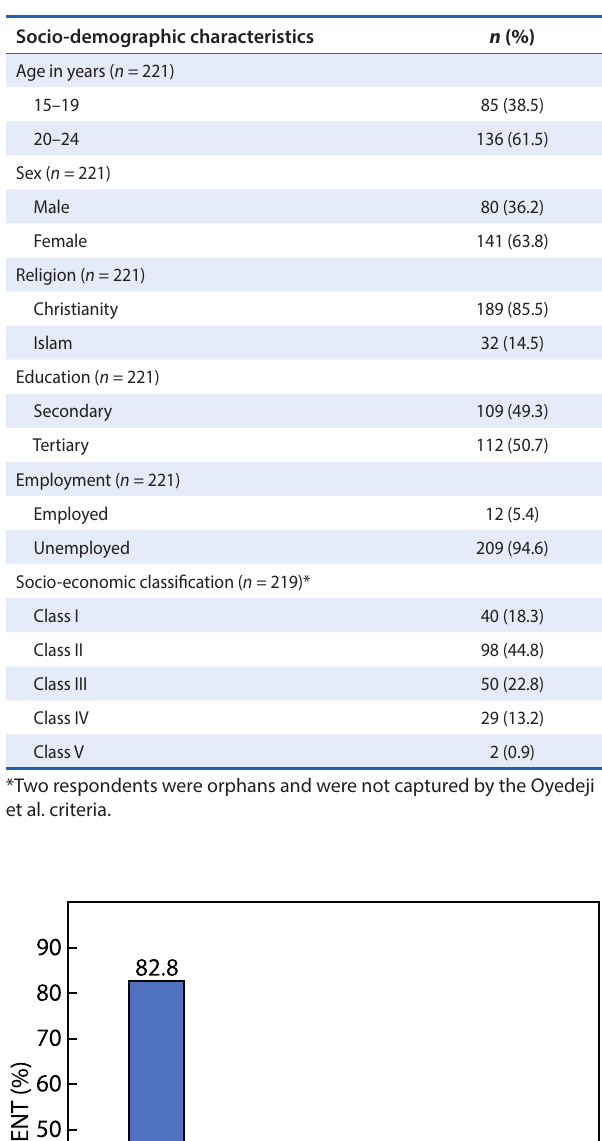
Table 1: Frequency distribution of respondents by socio-demographic characteristics